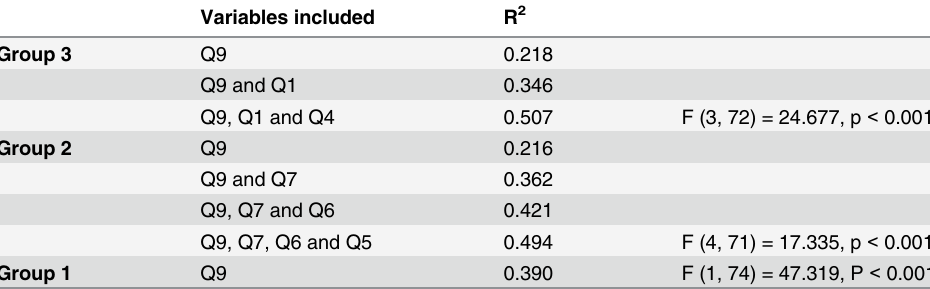
Table 5. Stepwise Multiple Regression